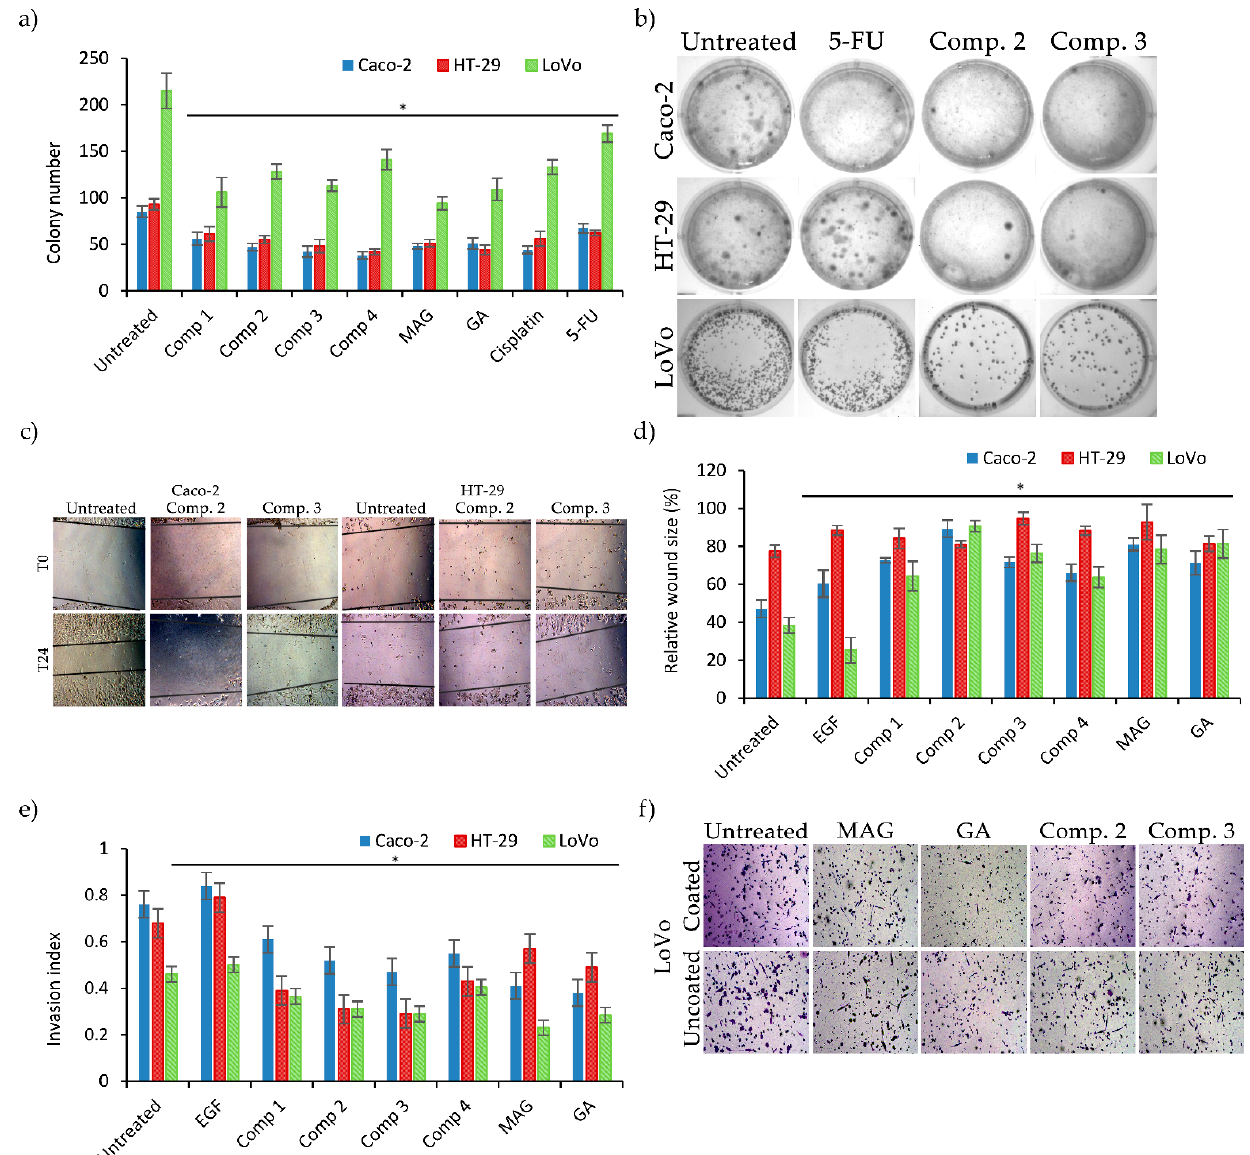
Figure 2. Antimetastatic activity of xanthones. ( a ) Results of clonogenic assays presented as the numbers of single colonies in culture plates. ( b ) Representative images of clonogenic assay ( c ). Representative images of the wound healing assay. ( d ) Migration of colon cancer cells estimated by the wound healing assay. ( e ) Invasion index values calculated for colon cancer cells after xanthone treatments. ( f ) Representative images of invasion assay on LoVo cell line. Graphs present mean values (+/ − S. D.); * indicates a significant difference ( p < 0.05) vs. untreated controls.